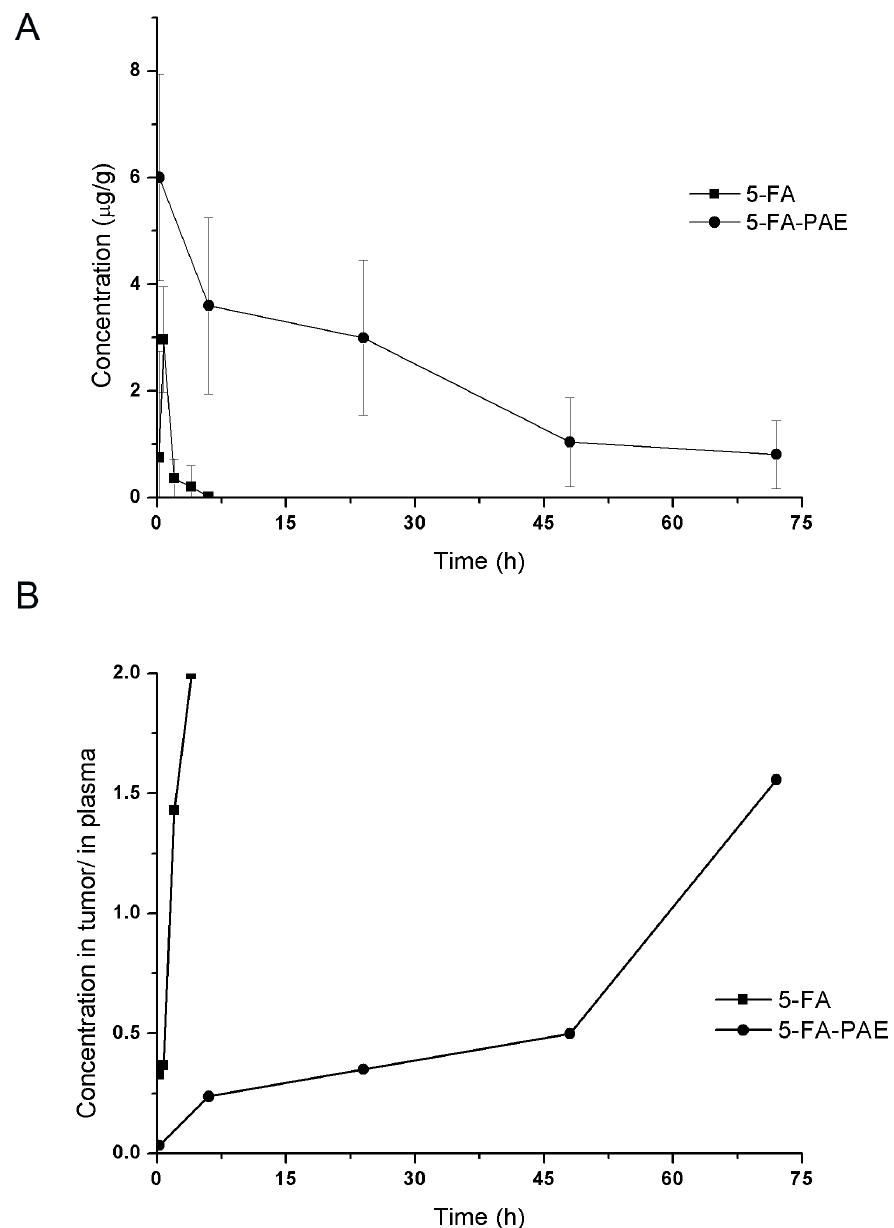
Figure 5. Drug concentration in tumor and plasma. The tumor-bearing mice model was described in the ‘‘ In vivo biodistribution’’ section. The control group and the test groups were administered intravenously with 20 mg/kg of 5-FA and 5-FA-PAE (equivalent to 20 mg/kg of 5-FA), respectively. (A) Drug concentration of 5-FA and conjugated 5-FA-PAE in tumor at different time points. (B) Ratio of drug concentration in tumor vs. that in plasma of 5-FA and conjugated